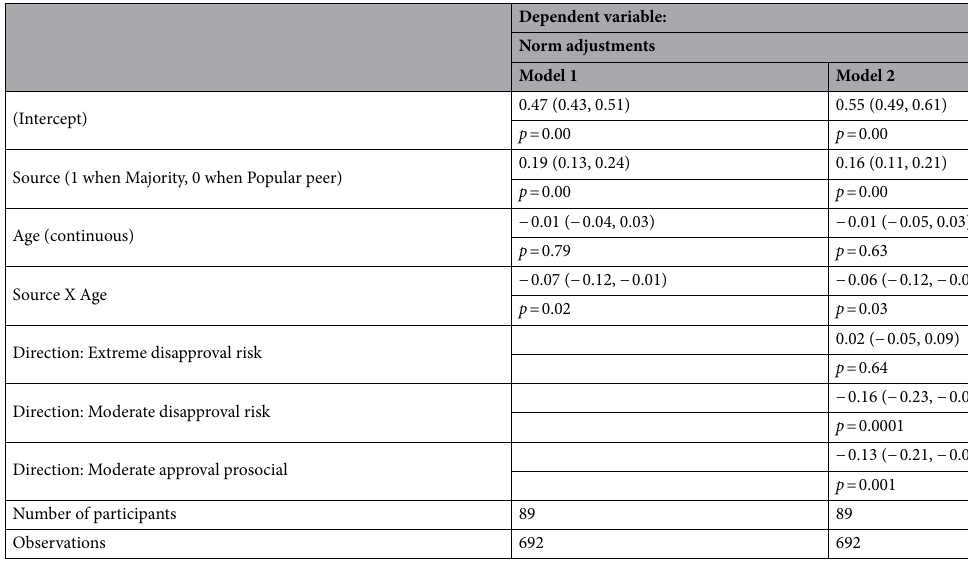
Table 1. Determinants of participants’ norm adjustment. Linear mixed-effects models were fitted to norm adjustments, using ‘participant’ as random intercept. Model 1 tested whether participants’ norm adjustments were influenced by the social source (popular peer or majority) and whether this effect was dependent on age (hypothesis 1). Model 2 tested whether participants’ norm adjustments were influenced by the direction of the peer norm (more moderate or more extreme peer disapproval or approval relative to one’s initial personal norm) and the domain of behaviour (hypothesis 2). Both models report unstandardized coefficients. The 95% confidence intervals (CI) are in parentheses and P values below the CI.